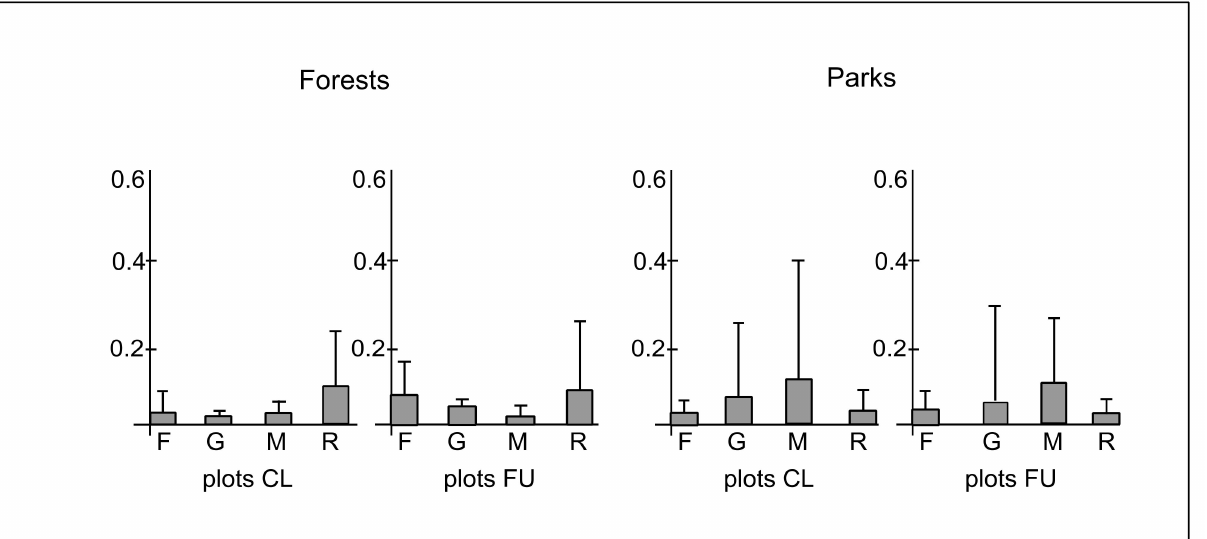
Figure 7. The mean (boxes) and standard deviation (whiskers) values of cover-abundance degree of species affiliated with different habitat types (F—forest, G—grassland, M—meadow, R—ruderal) per plot in closer (CL) and further (FU) plots located along paths in forests and